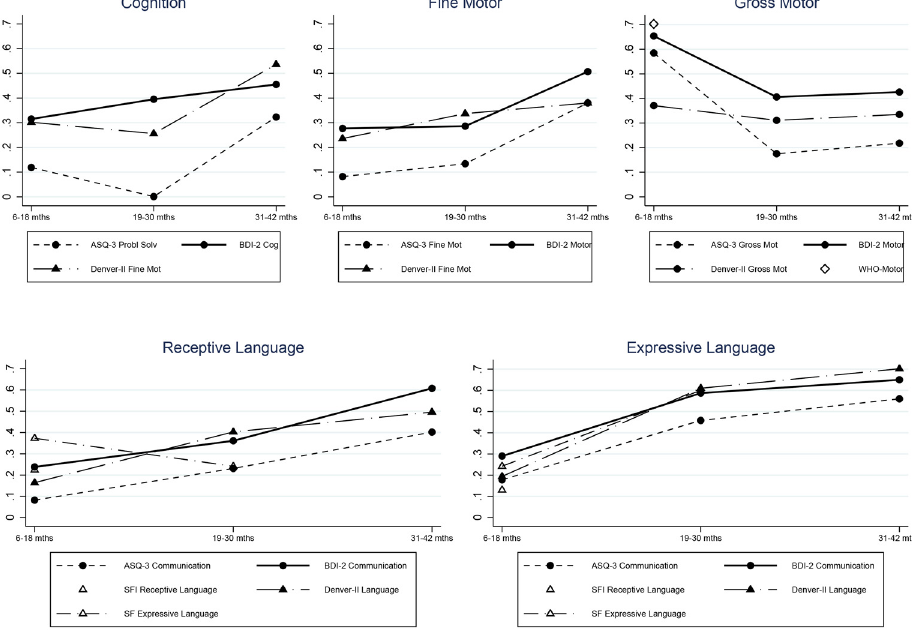
Fig 2. Concurrent Validity between the Bayley-III and the Short Tests by Matching Domain and Age